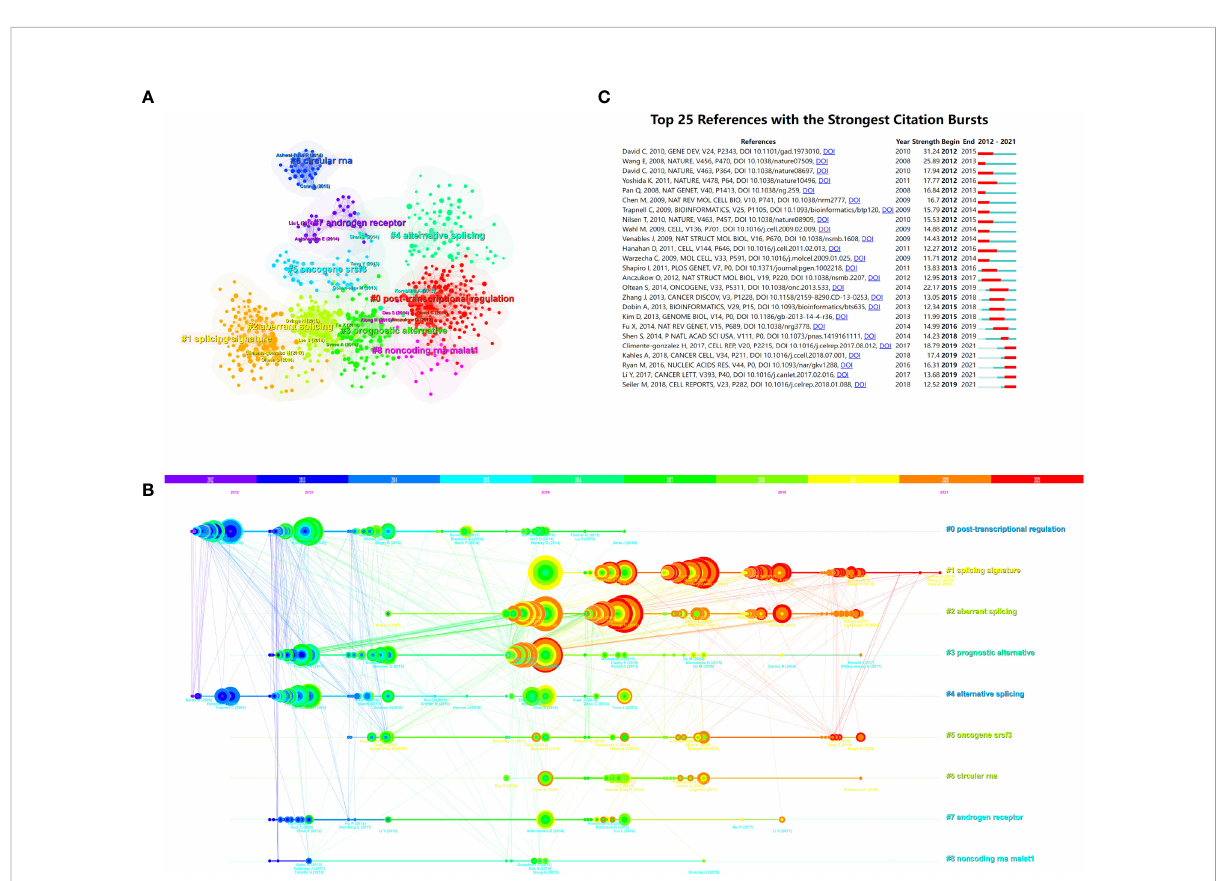
FIGURE 6 The reference co-citation analysis maps in (A) cluster view and (B) timeline view were produced by CiteSpace. (C) Visualization map of the top 25 references related to alternative splicing of cancer that have received the most citations. (B) Each cluster is represented as a horizontal axis; the larger the number of the cluster label, the smaller the cluster. The linkages show co-cited associations, and the node size represents co- citation frequencies. The node and line colors indicate distinct years. LLR used the title to extract cluster labels. (C) The red bars indicate citation burstness, whereas the blue bars indicate that the reference has been